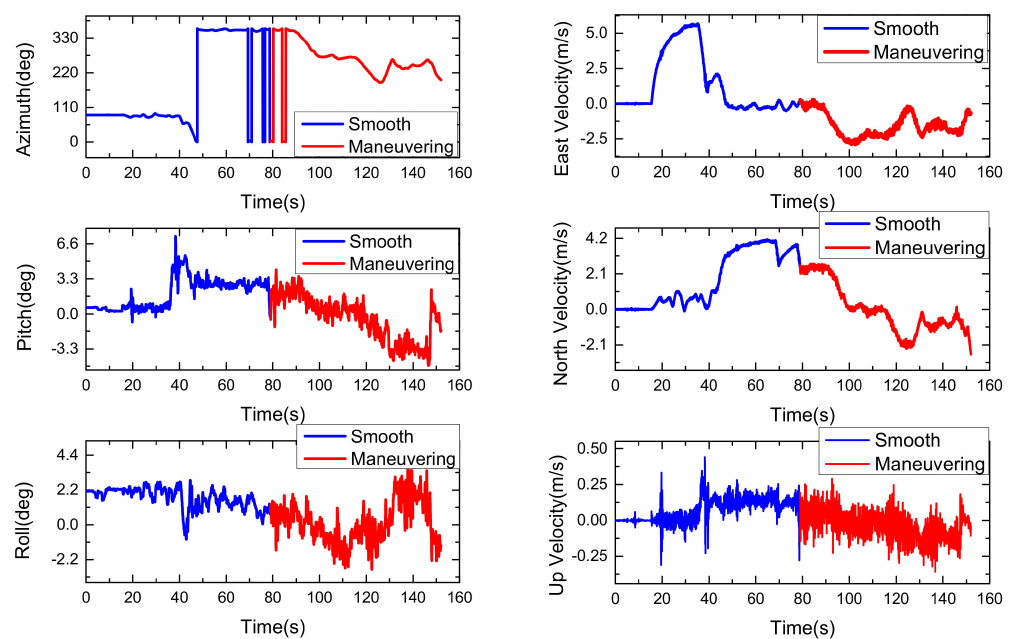
Figure 5. The reference attitude ( left ) and velocity ( right ) during the whole